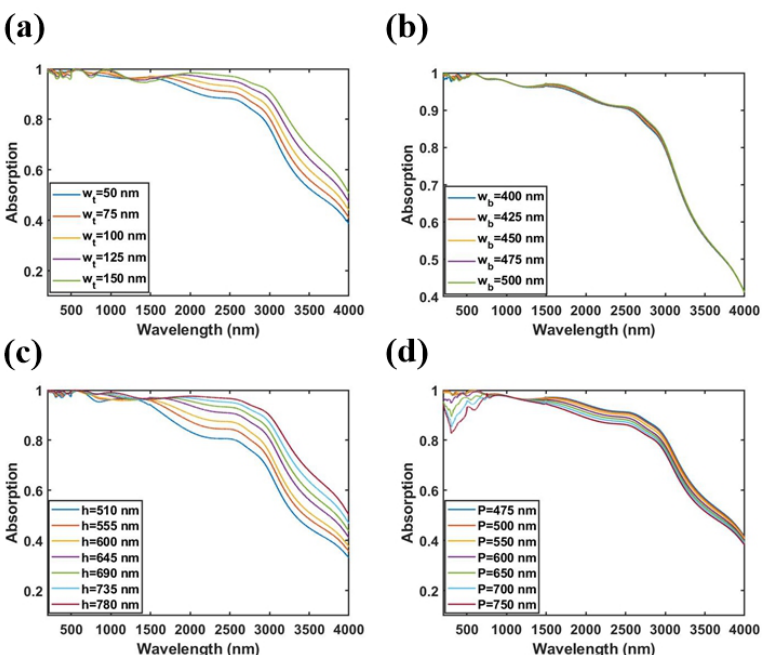
Figure 5. The influence of different structural parameters on the absorbing performance: ( a ) width of the top of the pyramid w t , ( b ) width of the top of the pyramid w b , ( c ) height of the pyramid h , and ( d ) period of the unit cell P .